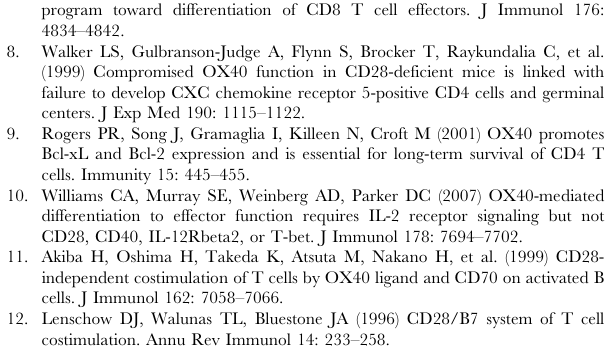
Figure S1 Proliferation of wild-type versus CD25-/- CD8 T cells. Naı¨ve polyclonal wild-type or CD25 2 / 2 CD8 T cells (3 6 10 5 /well) were CFSE-labeled and then stimulated with anti-CD3 and anti-CD28 (1 and 5 mcg/ml, respectively). One to three days later, CD8 T cells were harvested and the extent of proliferation (CFSE-dilution), A ) CD25, and B ) OX40 expression were determined. Data are representative of one out of two independent experiments with similar results. (TIF) Figure S2 Effects of dual anti-OX40/IL-2c therapy on the accumulation of Treg. A ) 2.5 6 10 6 TRAMP-C1-mOVA tumor cells were injected into POET-1 mice. Twenty days later, tumor-bearing mice received 5 6 10 5 naı¨ve OT-I T cells. Seventeen days after T cell adoptive transfer, the donor OT-I T cells were re- stimulated with anti-OX40 or control Ab, OVA/LPS, and IL-2 cytokine/mAb complexes (as in Fig. 8). A ) The percentage of FoxP3 + /CD4 + T cells in the peripheral blood (pre- and post- therapy) was determined by flow cytometry. B ) When tumors progressed to . 150 mm 2 , the tumor-bearing mice were eutha- nized and the percentage of FoxP3 + CD3 + CD4 + T cells in the lymph nodes and tumor were determined by flow cytometry. Data represent the mean + / 2 SD from individual mice pooled from 2 independent experiments (n =5–10). *P , 0.01.